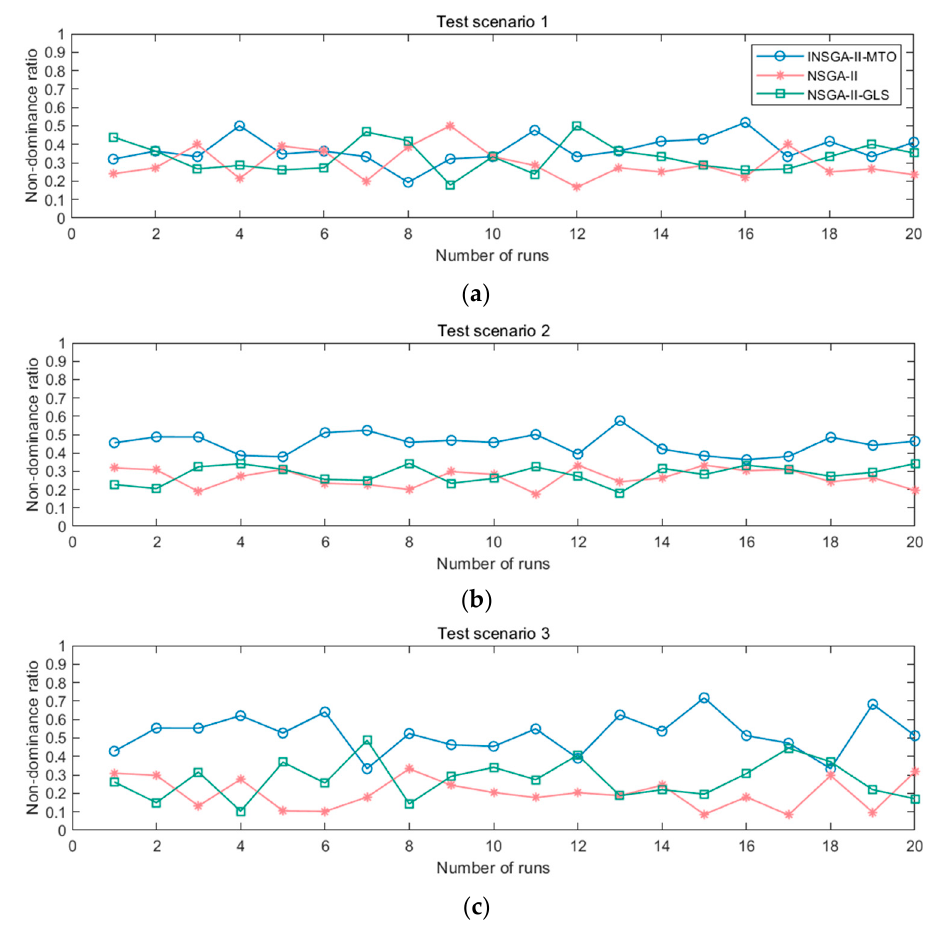
Figure 9. The NR values of three algorithms. ( a ) The NR values obtained by three algorithms in scenario 1. ( b ) The NR values obtained by three algorithms in scenario 2. ( c ) The NR values obtained by three algorithms in scenario 3.